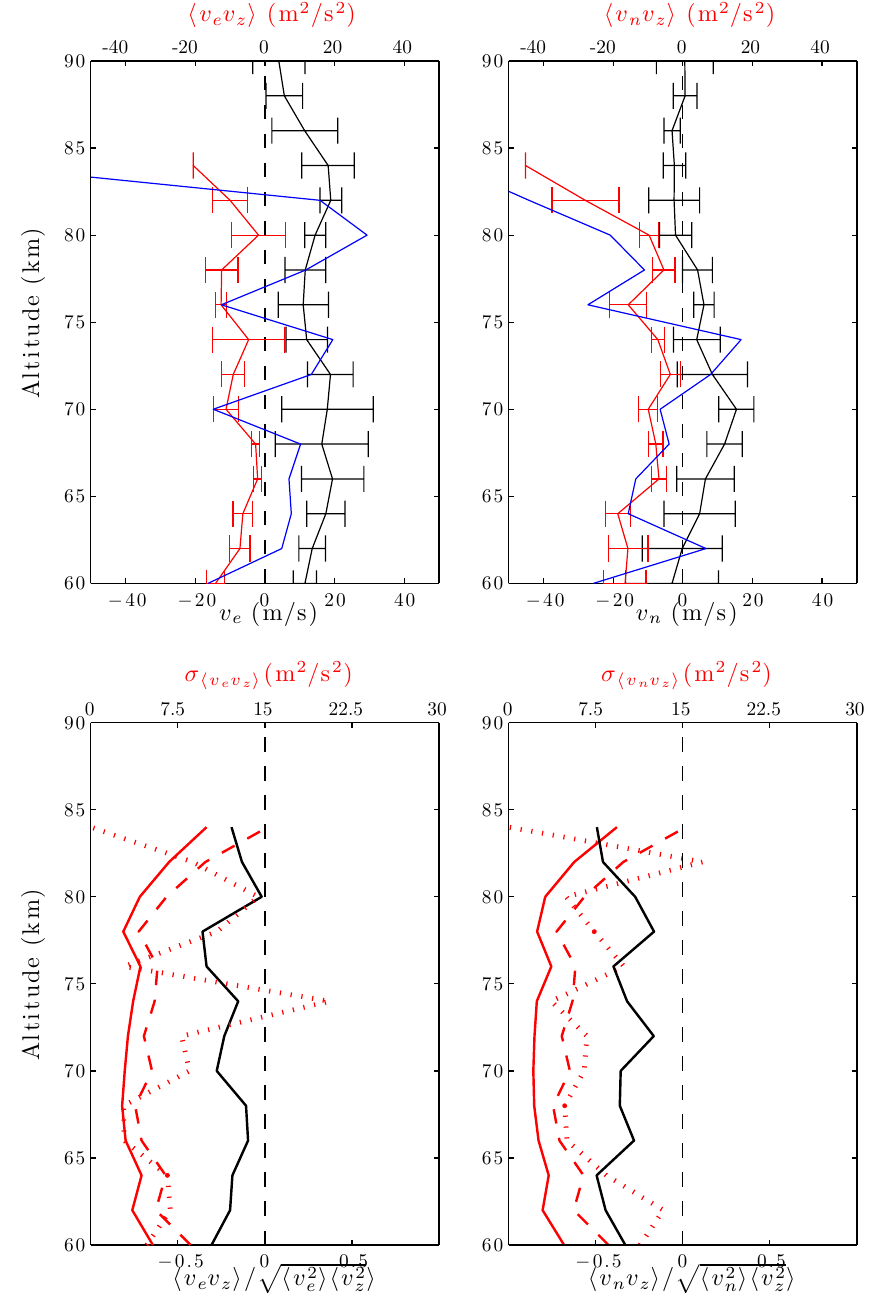
Fig. 11. Same as Fig. 9 for the period 18:00–24:00UT on 21 December 2007.